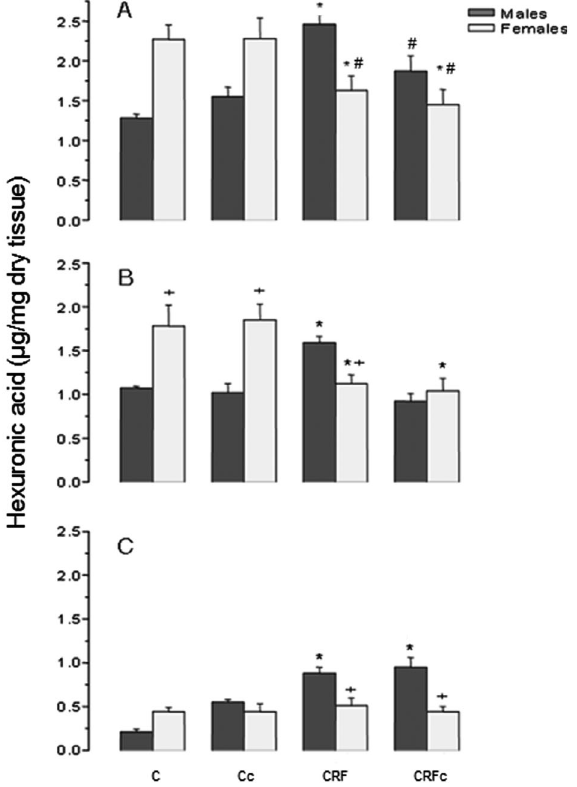
Figure 4. Total glycosaminoglycans ( A ), heparan ( B ), and chondroitin++dermatan sulfate ( C ) in kidneys from male and female rats. C: control; c: castration; CRF: chronic renal failure. P , 0.05: * vs respective control groups; + vs males; # vs male CRF.